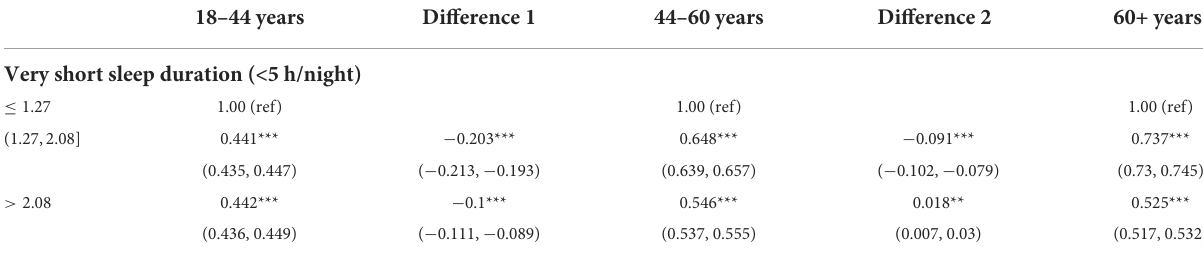
TABLE 4 Bootstrapped odds ratios (95% confidence intervals) of very short sleep (reference, 7–9 h/night) across tertiles of body weight-adjusted dietary ALA intake and differences between adjacent age groups (95% bootstrapped percentile confidence intervals), stratified by age, NHANES